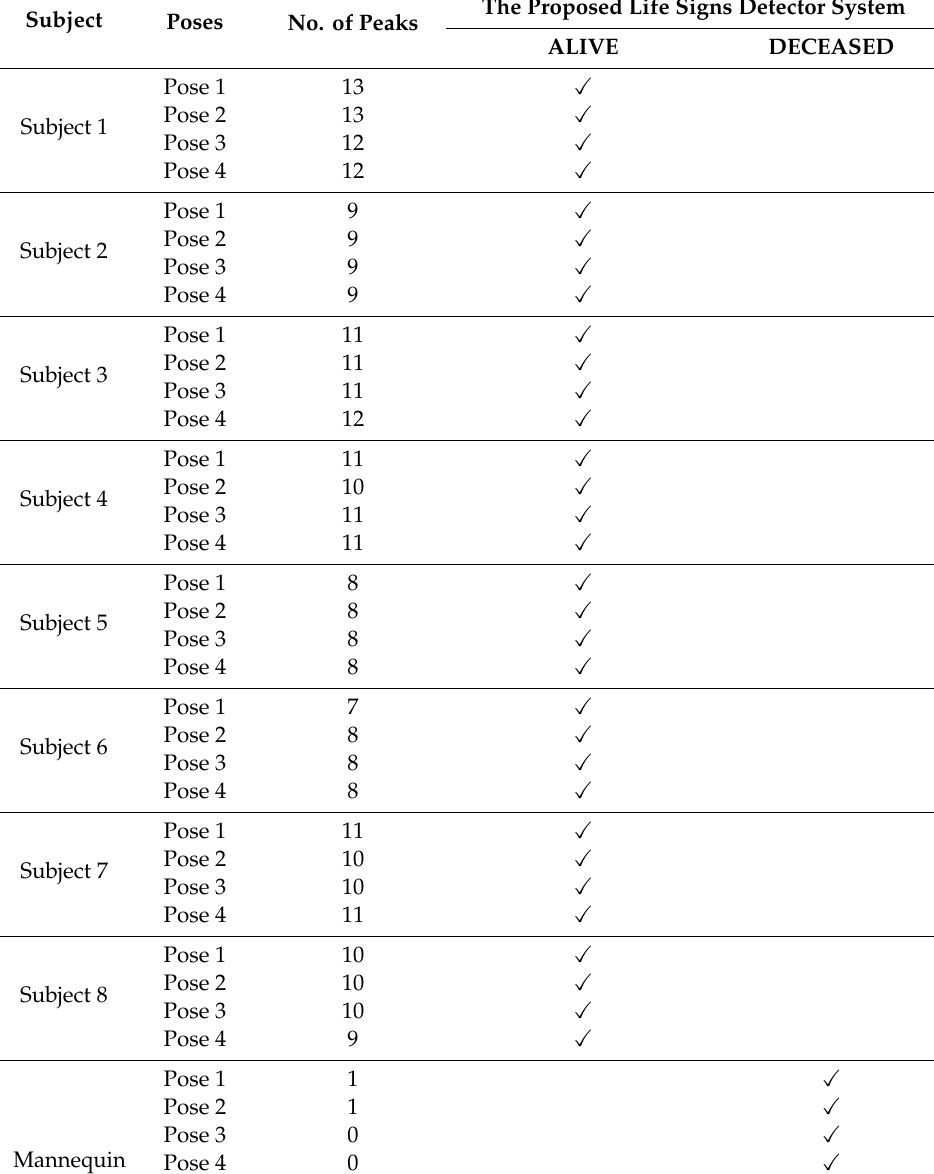
Table 1. The experimental results of eight human subjects and one mannequin at di ff erent poses. The Proposed Life Signs Detector No. of Peaks